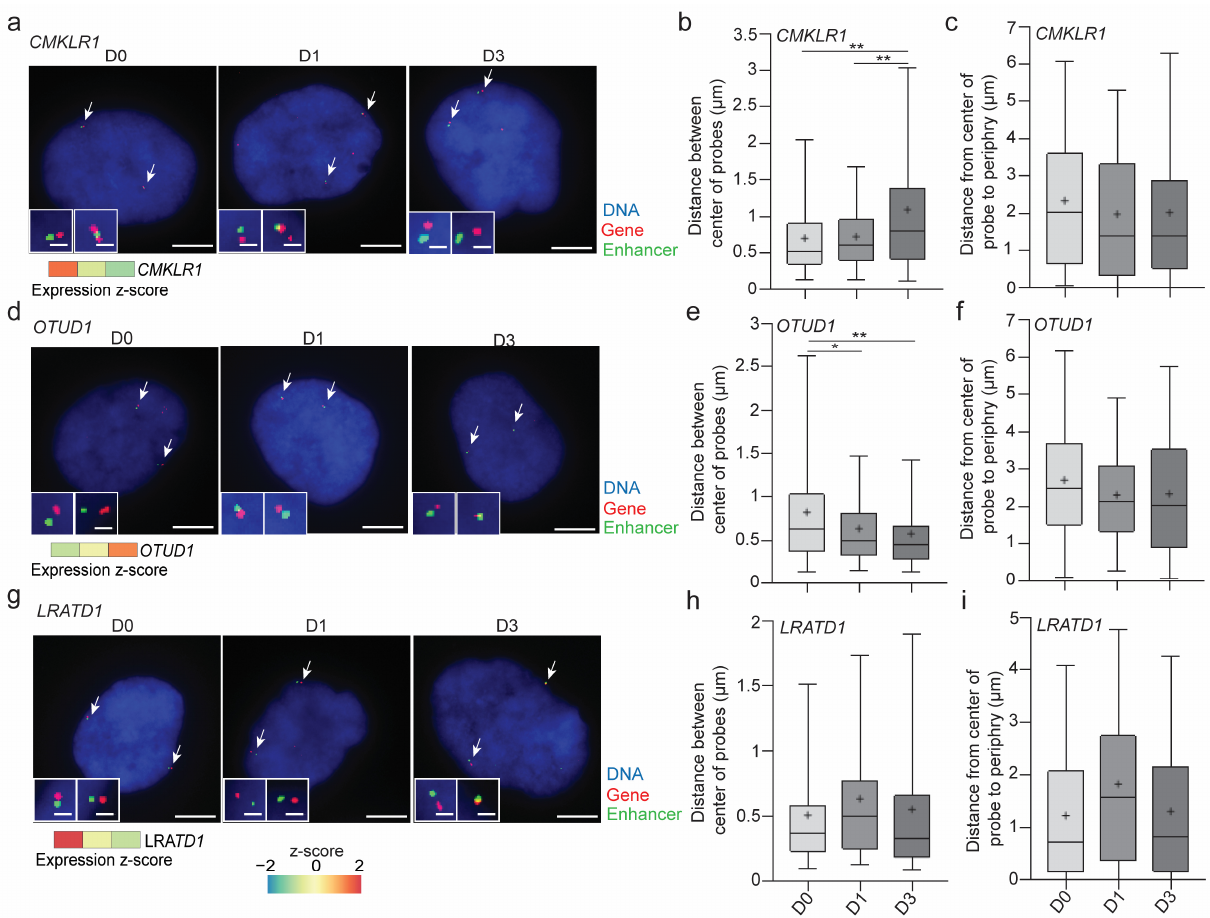
Figure 3. FISH analysis of gene-enhancer distances within LADs during early adipogenic differentiation. ( a – c ) CMKLR1 locus: ( a ) FISH images of changes in proximity of the CMKLR1 gene (red probe) and a putative (GeneHancer-predicted and ECHi-C-predicted) enhancer 480 kb away (green probe) on D0, D1 and D3 of differentiation; blue, DAPI; scale bars, 5 μ m in main, 0.5 μ m in insets; a z-score RNA-seq heatmap is shown for D0, D1, D3 (left to right), adapted from [10]; ( b ) probe-probe distances; ** p = 0.04; unpaired two-tailed t -test; ( c ) distances from probe to nuclear periphery outlined by DAPI staining (green probes). ( d – f ) FISH analysis of the OTUD1 locus and a putative enhancer 348 kb away, as in ( a – c ); * p = 0.08, ** p = 0.04; unpaired two-tailed t -test. ( g – i ) FISH analysis of the LRATD1 locus and a putative enhancer 510 kb away, as in ( a – c ). For all loci, n = 50 nuclei each with two green and two red FISH signals; box plots: bar, median; cross, mean; box, 25–75% percentile; whiskers,